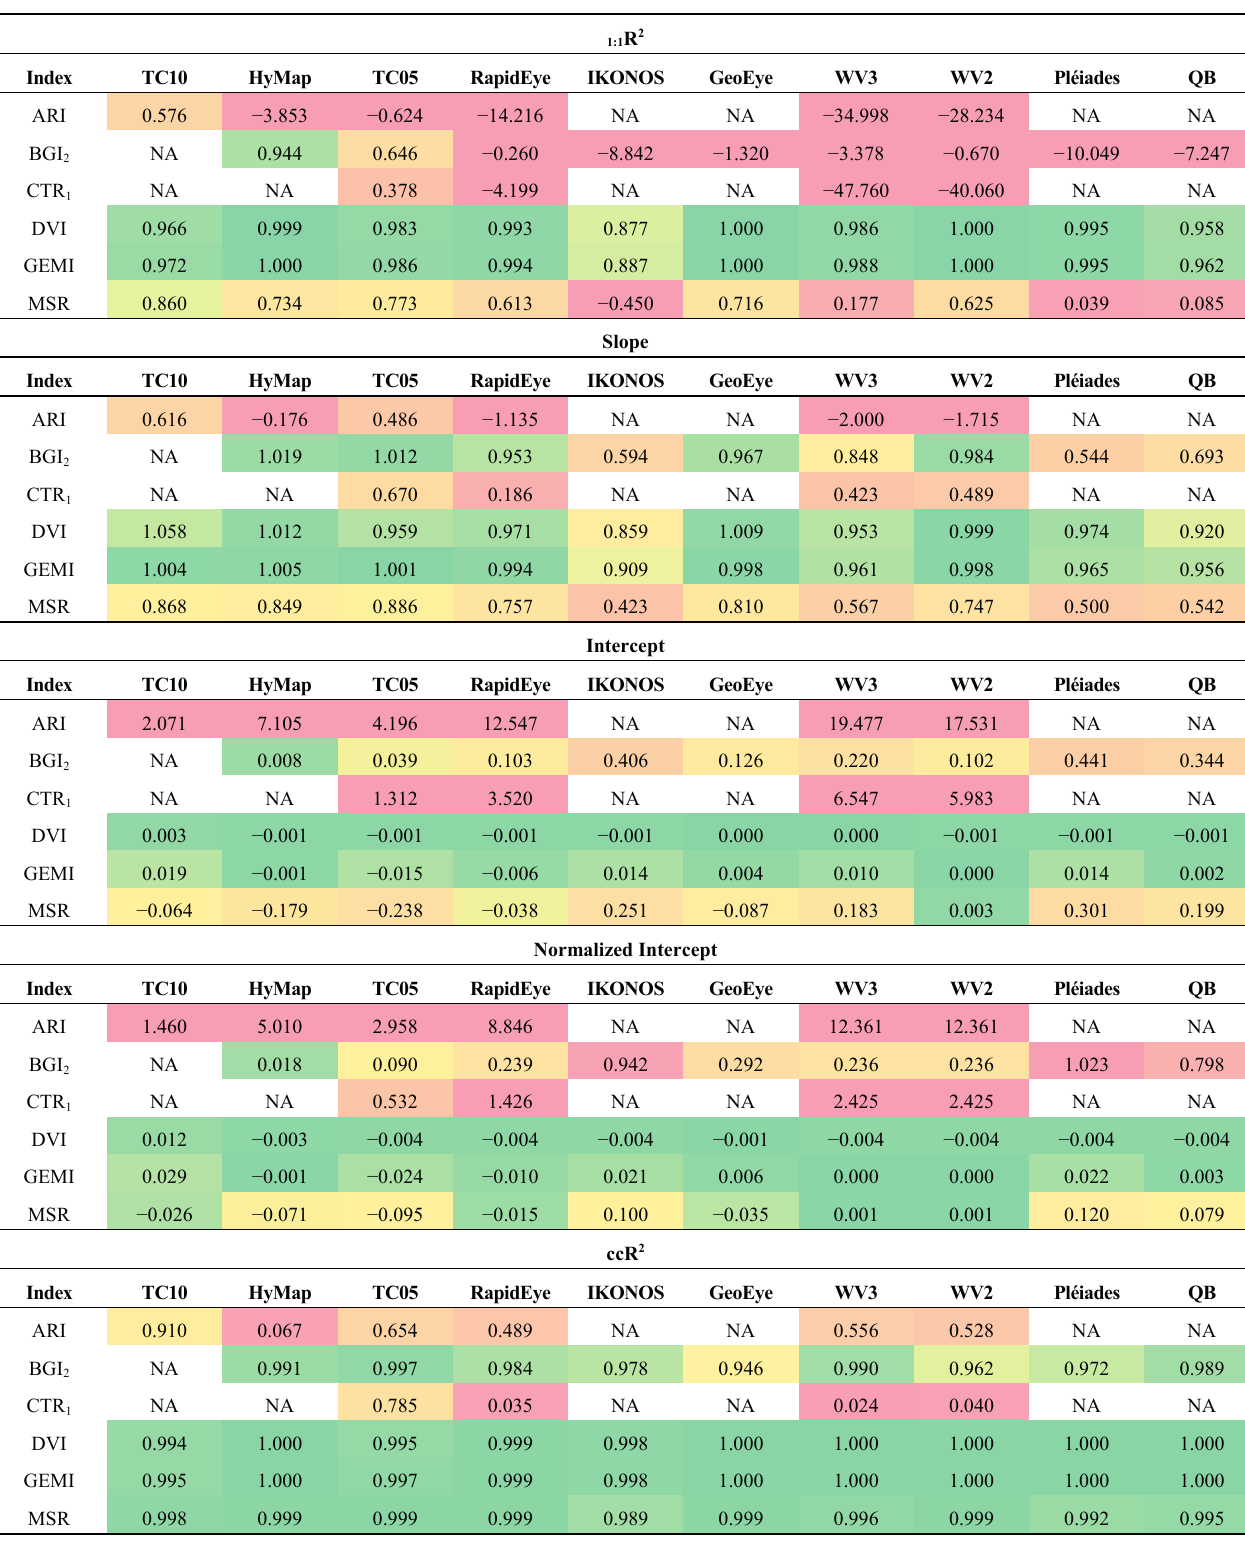
Table 2. Individual statistical measures per sensor for representative indices, namely Difference Vegetation Index (DVI) and Global Environmental Monitoring Index (GEMI) representative of the overall performing well group, Anthocyanin Reflectance Index (ARI) and Carter Index 1 (CTR 1 ) of the overall performing poorly group and Blue/Green Index 2 (BGI 2 ) and Modified Simple Ratio (MSR) of the mixed performance group. 1:1 R